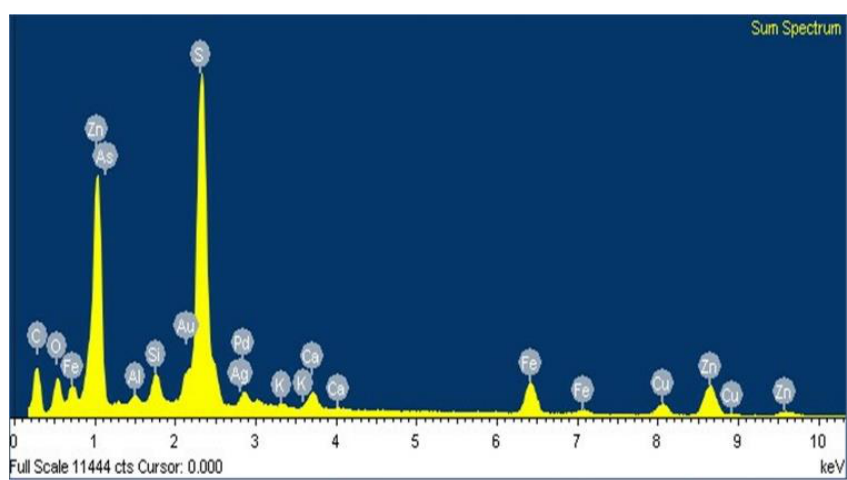
Figure 4. Energy-dispersive X-ray spectrum performed on an all-in-one powder sample of Zn concentrate.